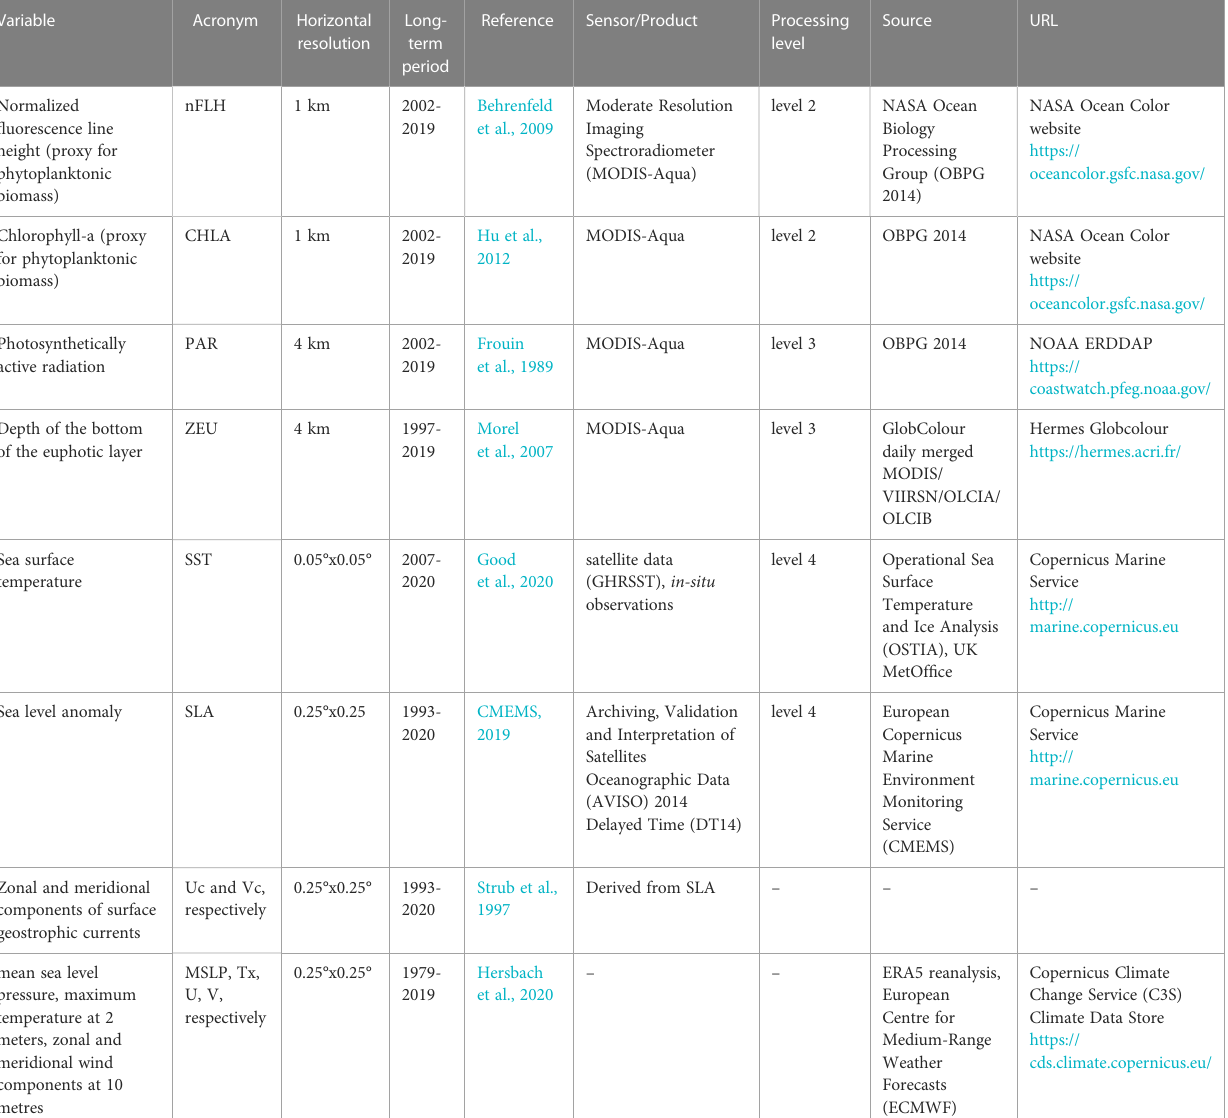
TABLE 1 Satellite products and reanalysis variables used in this